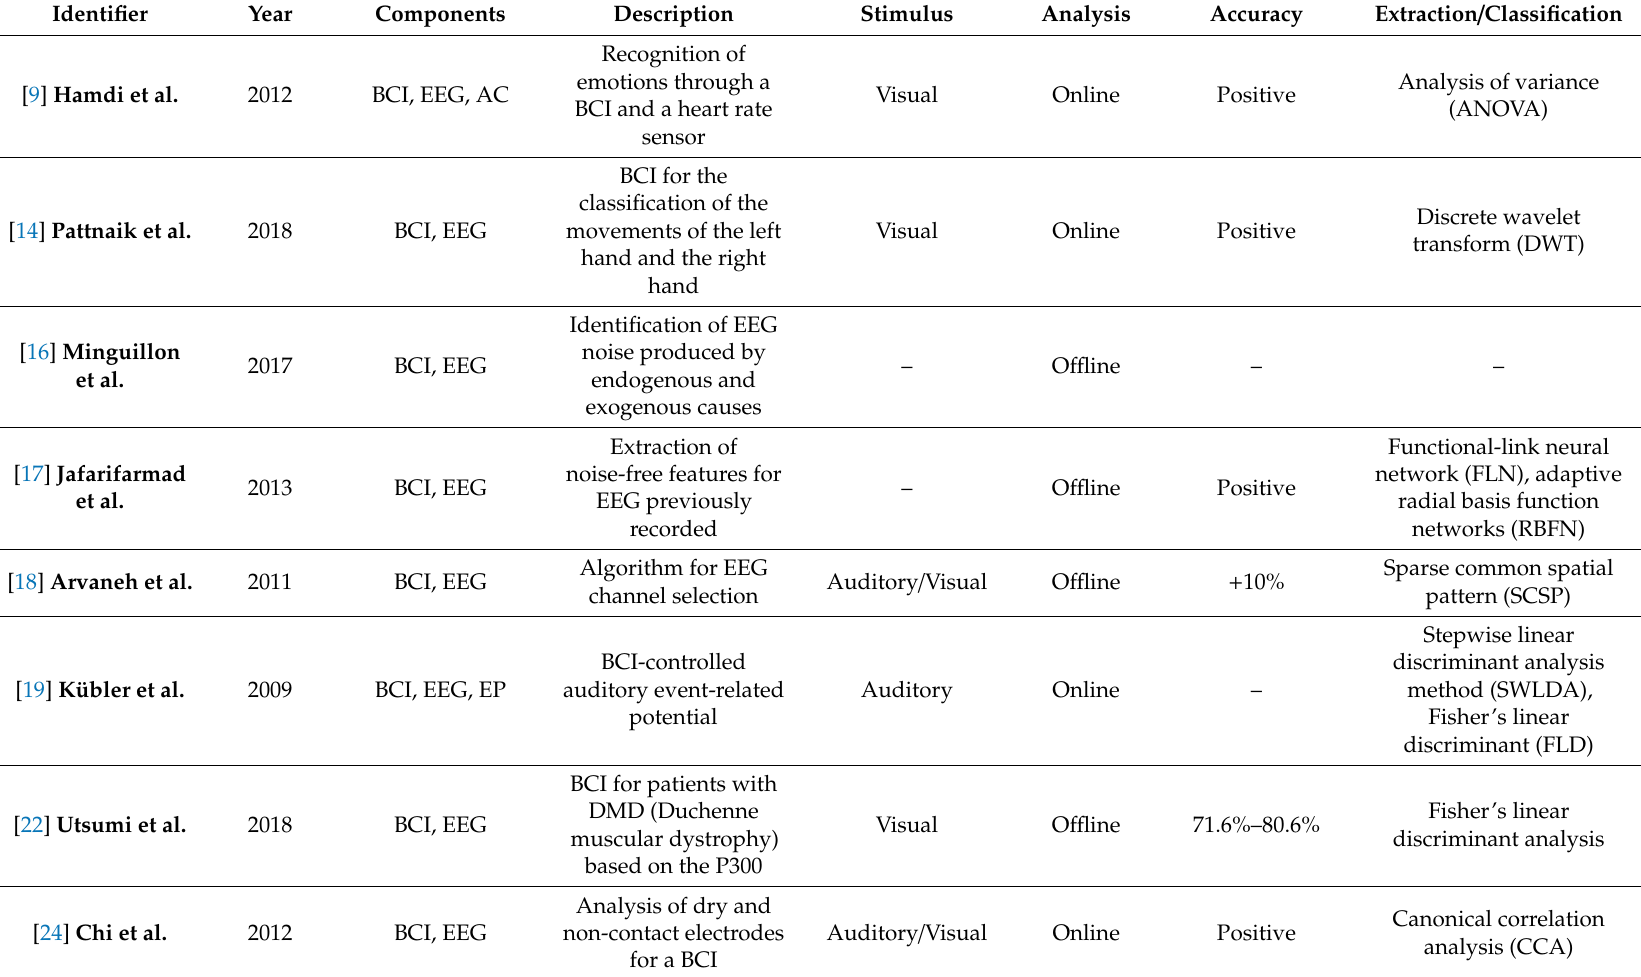
Table 1. Brain–computer interface and a ff ective computing for people with a visual